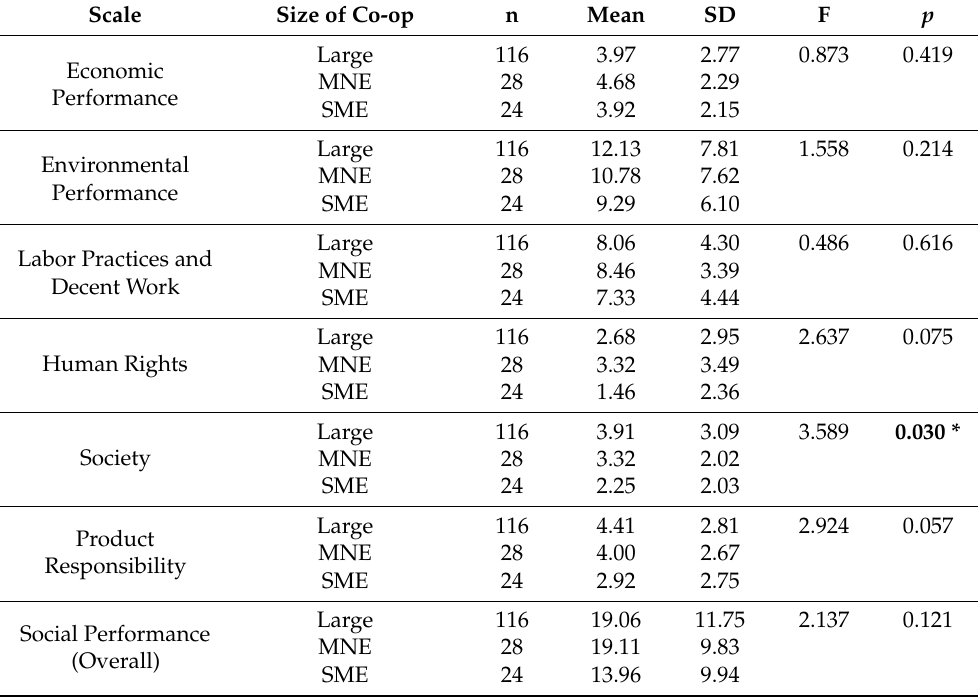
Table 7. Analysis of variance (ANOVA) test results for the comparison of the economic, environmen- tal, and social performance indicator disclosures subject to cooperative size. Scale Size of Co-op